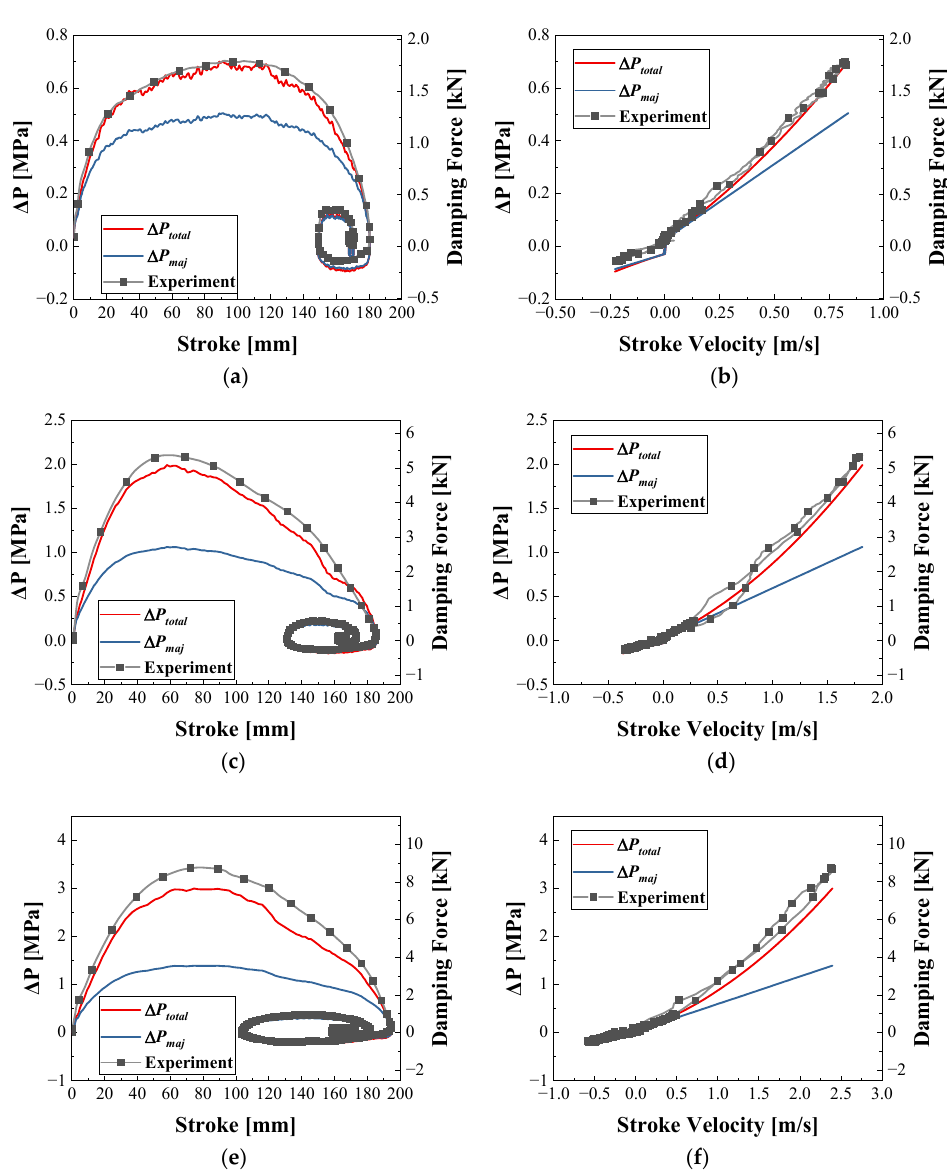
Figure 7. Pressure drop and estimated damping force considering ∆ P total and ∆ P maj models and experimental data: ( a ) for stroke and impact energy of 456.7 J; ( b ) for stroke velocity and impact energy of 456.7 J; ( c ) for stroke and impact energy of 937.5 J; ( d ) for stroke velocity and impact energy of 937.5 J; ( e ) for stroke and impact energy of 1538 J; ( f ) for stroke velocity and impact energy of 1538 J. Table 2. Dissipated energy in MR shock absorber for impact energy; RMS values of error for model-based and measured pressure data over stroke velocity range of 0.1 m/s or more.